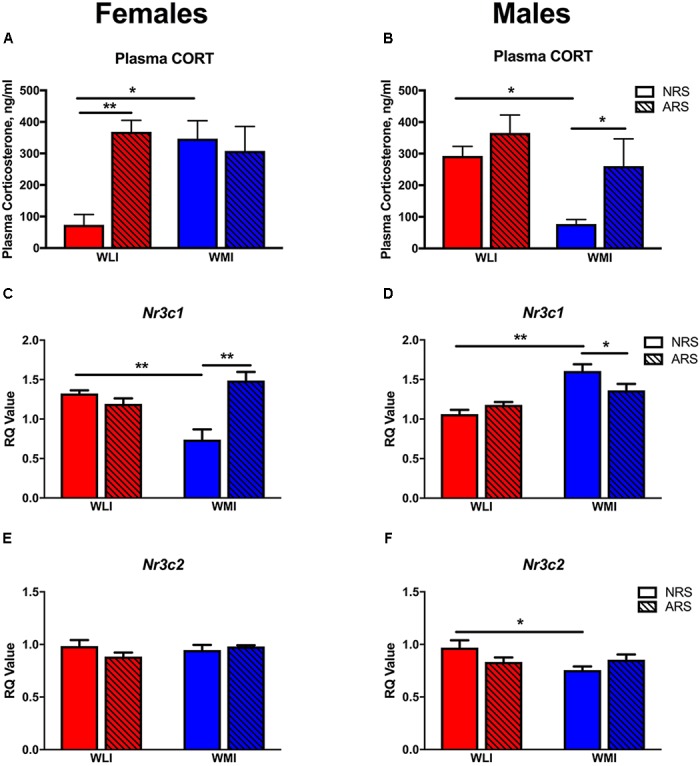
Plasma corticosterone and hippocampal glucocorticoid and mineralcorticoid receptor expression. CORT levels were significantly higher in NRS WMI females (A) and NRS WLI males (B) compared to the other strain. Acute restraint stress resulted significantly higher CORT levels in the WLI females and WMI males compared to their NRS counterparts (A,B), respectively. Hippocampal Nr3c1 transcript levels showed the opposite pattern to that of plasma CORT. Nr3c1 expression is decreased in the NRS WMI female (C) and in the NRS WLI male (D) compared to the other strain in the NRS condition. Acute stress increased Nr3c1 expression in the WMI female but decreased it in the male hippocampus (C,D), respectively. Hippocampal Nr3c2 transcript levels showed no significant differences in females (E), but decreased expression in NRS WMI compared to NRS WLI (F). Plasma CORT levels, were measured by ELISA, in samples collected 48 h after the restrain stress or no stress applied. Transcript levels were measured in the hippocampus collected at the same time. The RT-PCR used GAPDH as the housekeeping gene and a general calibrator. Relative quantification (RQ) employed the 2-ΔΔCt method. Values are shown as mean ± SEM; ∗p < 0.05; ∗∗p < 0.01. NRS, no stress; ARS, acute restraint stress; CORT, corticosterone; Nr3c1, glucocorticoid receptor; Nr3c2, mineralcorticoid receptor. WLI NRS male n = 5(CORT), 4(Nr3c1), 6(Nr3c2); NRS female n = 6(CORT), 5(Nr3c1), 8(Nr3c2); ARS male n = 4(CORT), 5(Nr3c1), 5(Nr3c2); ARS female n = 6(CORT), 6(Nr3c1), 6(Nr3c2); WMI NRS male n = 5(CORT), 4(Nr3c1), 6(Nr3c2); NRS female n = 4(CORT), 4(Nr3c1), 8(Nr3c2); ARS male n = 4(CORT), 5(Nr3c1), 5(Nr3c2); ARS female n = 6(CORT), 6(Nr3c1), 6(Nr3c2).